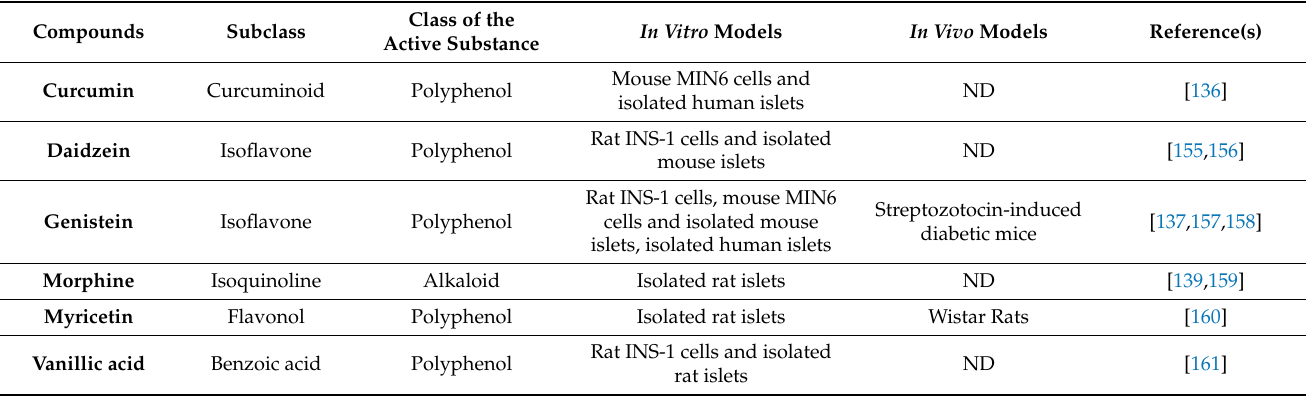
Table 5. Polyphenols and alkaloids that stimulate insulin secretion via a rise in cAMP